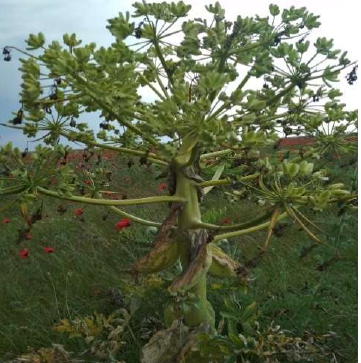
Fig. 2. Ferula asafoetida L. growing in the Kazakhstan region Turkestan